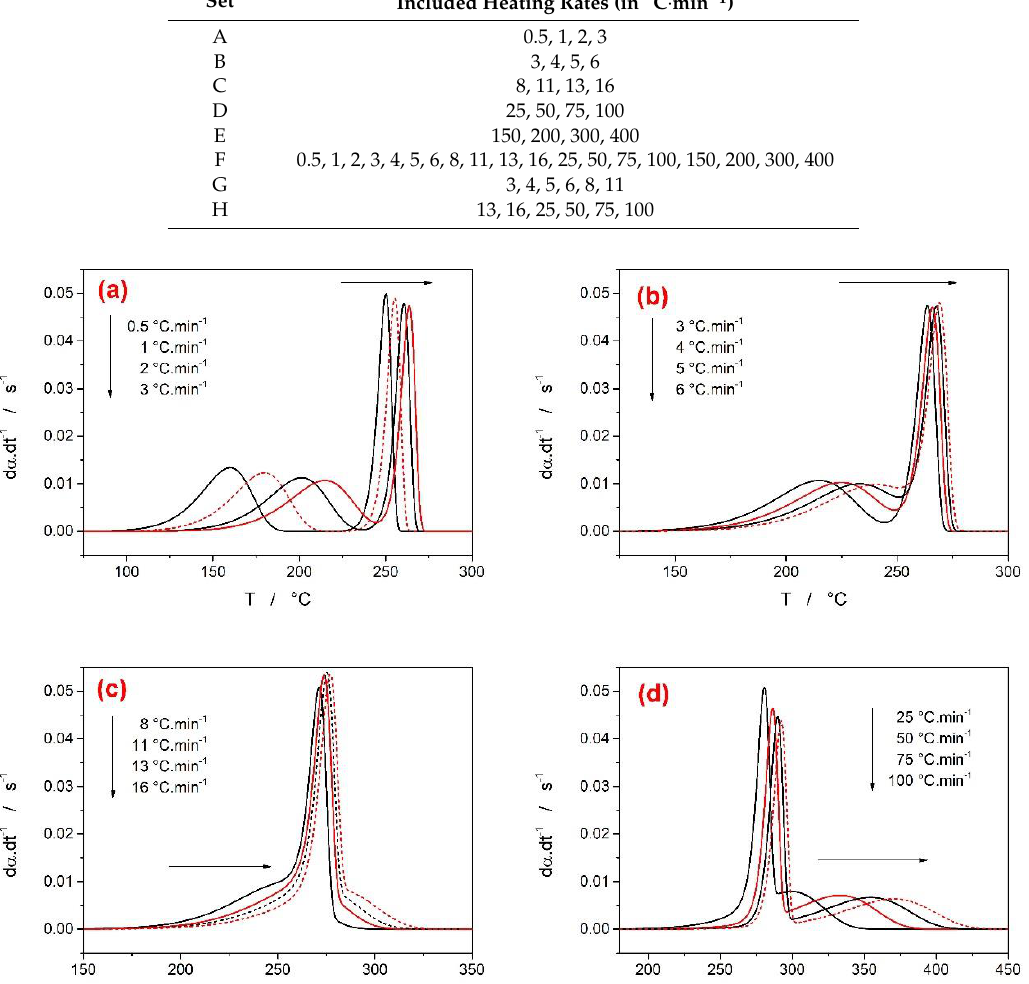
Table 2. Kinetic curves included in datasets simulated within the second group of scenarios.